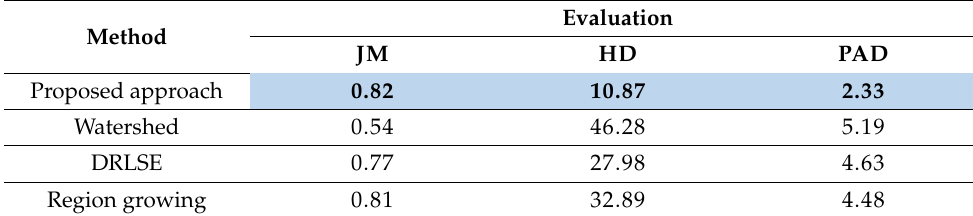
Table 3. Localization result comparation.